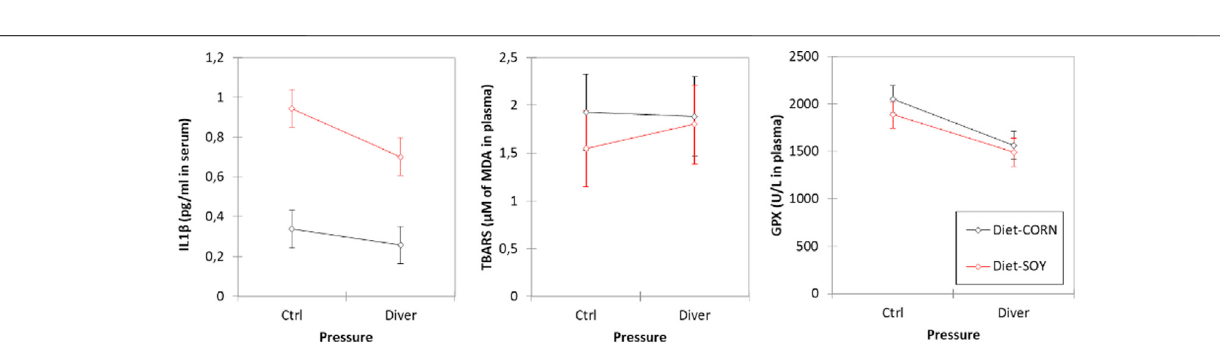
FIGURE 3 | In fl ammation and oxidative stress markers in plasma of Control and Diver rats, according to their diet (MAIZE or SOY): IL-1 β , TBARS and GPX activity evaluation.